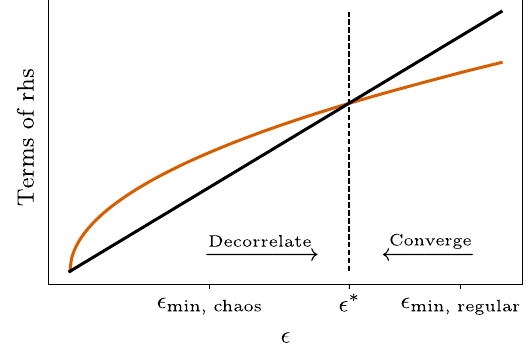
FIG. 3. Fixed-point average distance between replicas implies ffiffiffi p ϵ chaotic subspace. The square-root term ∝ (dark orange curve) and the linear term ∝ ϵ in Eq. (12) intersect and produce a fixed point ϵ (cid:3) for the covariance Q ð 0 Þ − ϵ between the two replicas. The resulting average Hamming distance d (cid:3) between states in the two copies of the system is given by ϵ (cid:3) and Eq. (16) as d (cid:3) ¼ N ϵ (cid:3) =g 2 . Depending on whether ϵ , the minimum decor- min relation due to a single flipped spin, is smaller or larger than ϵ (cid:3) , the replicas will either decorrelate, or they will converge and forget the ffiffiffiffiffi 2 p ffiffiffi ϵ (cid:3) : ð 13 Þ p g 2 h T 0 ð h Þi ¼ h π